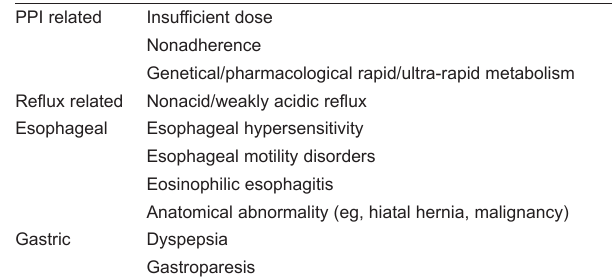
TAble 2 Causes of proton pump inhibitor (PPI) failure